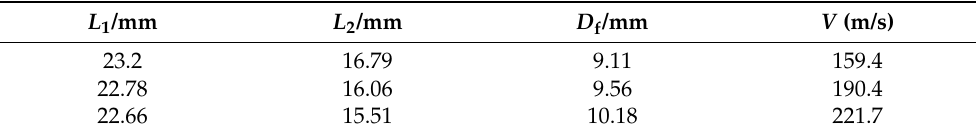
Table 1. The size of the Taylor impact specimens at different